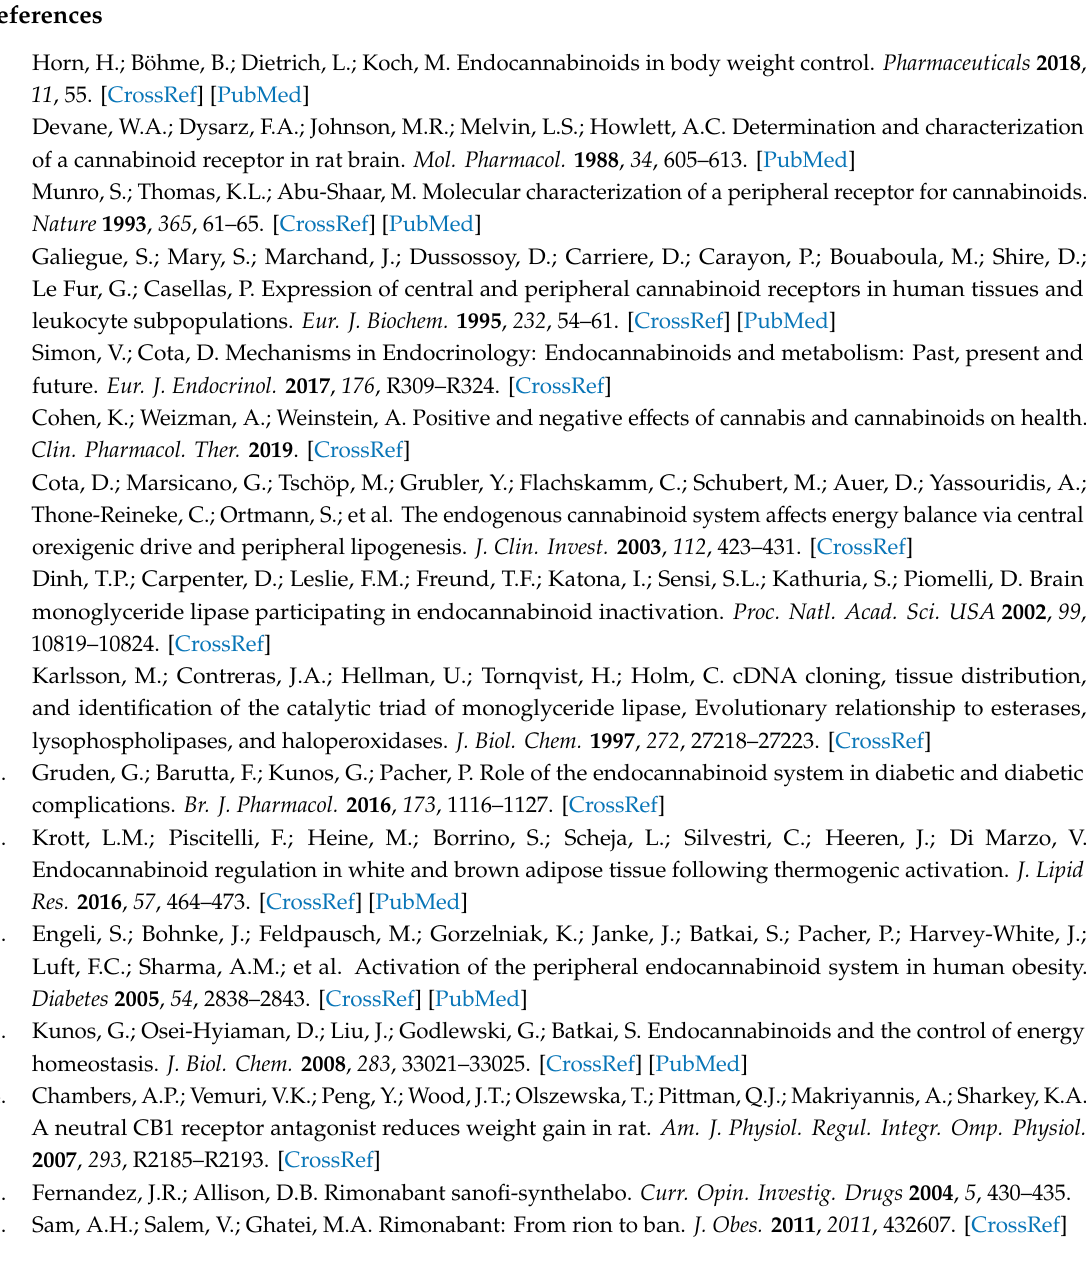
Table S1: E ff ect of cytochalasin B and triacsin C on lipogenesis and lipolysis, Supplementary Table S2: Purification and lipid composition of LD, Supplementary Table S3: PKA-dependent phosphorylation of HSL and LD in vitro , Supplementary References